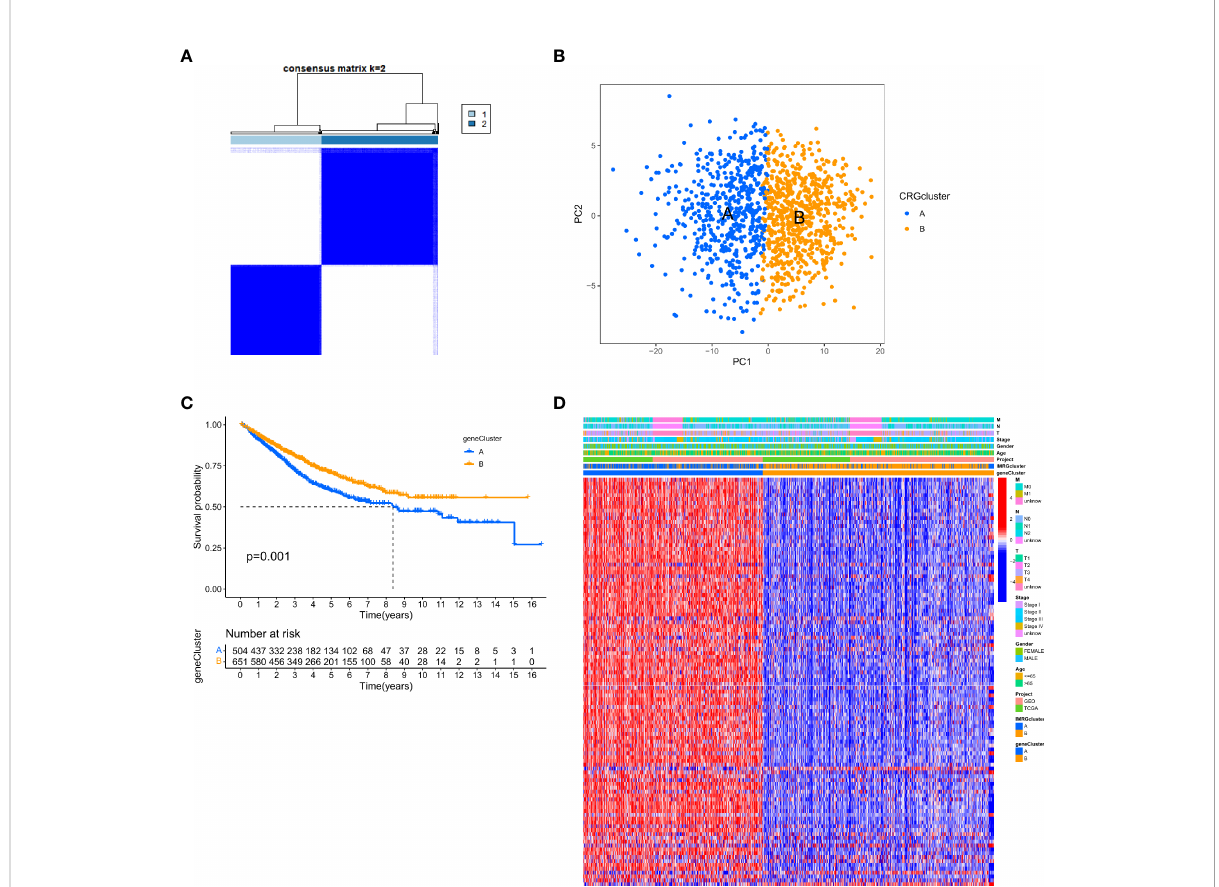
FIGURE 3 Identi fi cation of gene subtypes based on DEGs. (A) The consensus clustering matrix (k=2) classi fi ed the COAD patients into 2 different genomic subtypes; (B) PCA demonstrates variability between the two gene subtypes; (C) Differential analysis of OS for the 2 gene clusters; (D) Relationship between 2 gene clusters and clinicopathological